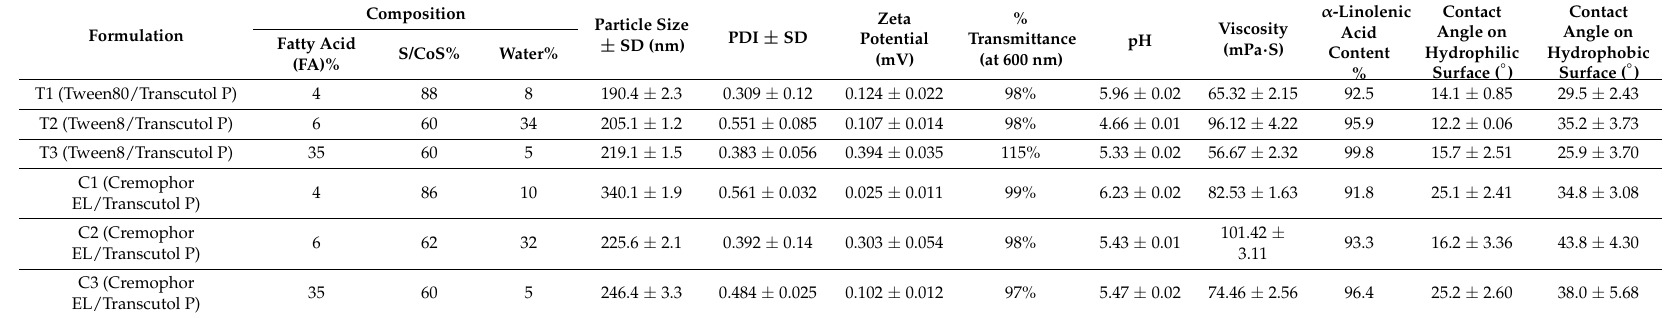
Table 1. Composition and characterisation criteria of the selected microemulsion formulations, fatty acid microemulsions were characterised for their particle